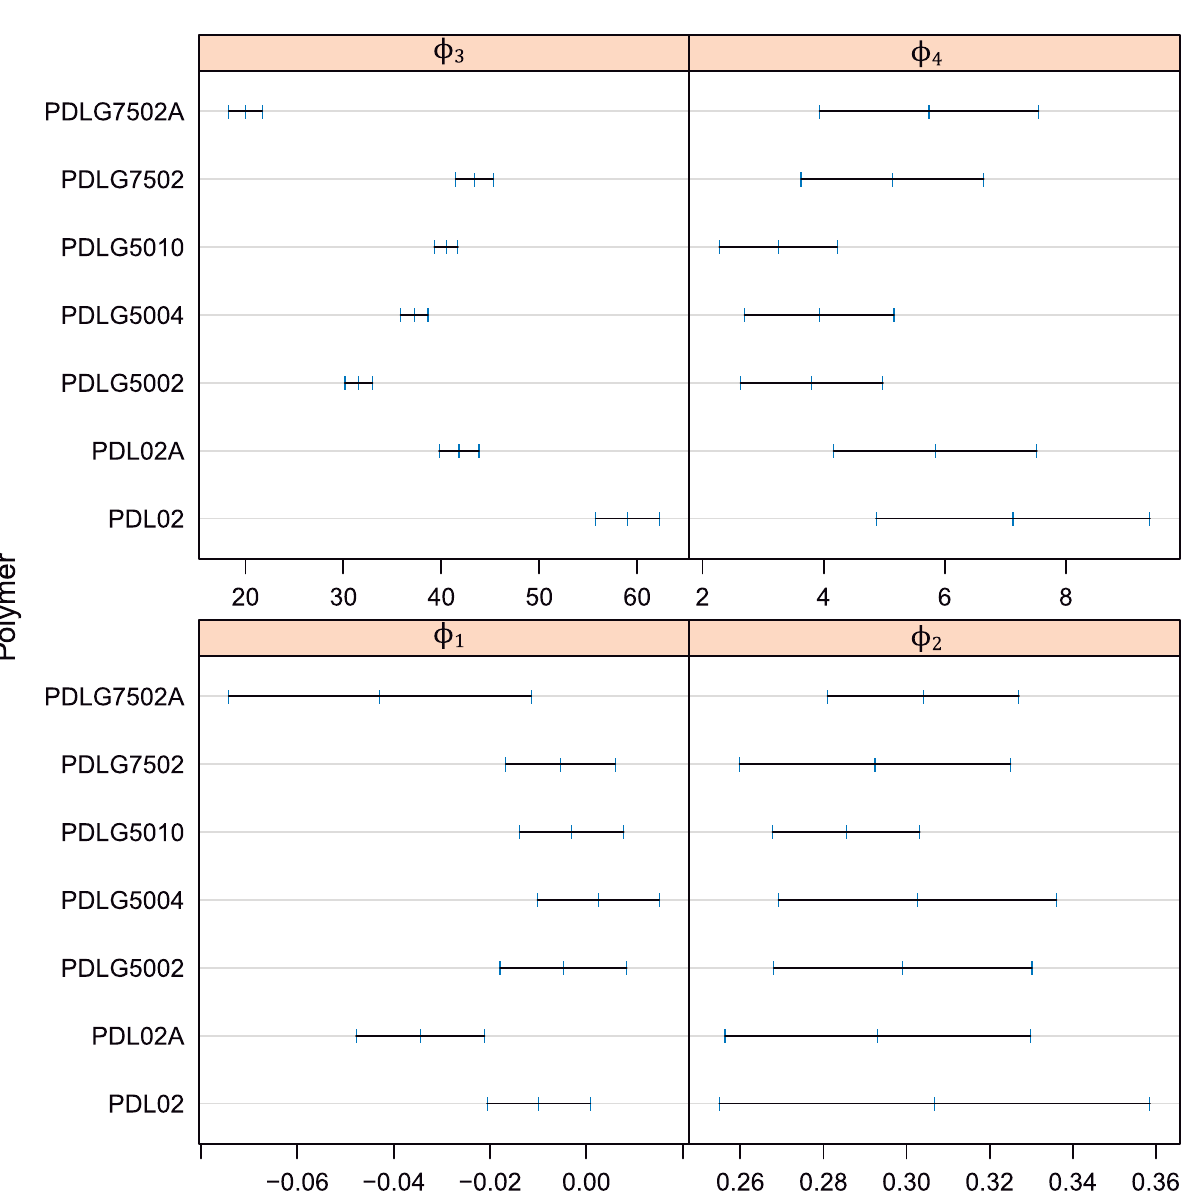
Fig 7. Confidence intervals (at 95% confidence level) for the parameters of the nonlinear model of mass loss versus time an PDLGA formulation, with only fixed effects. Parameters intervals are obtained from the 2 × 7 fittings.